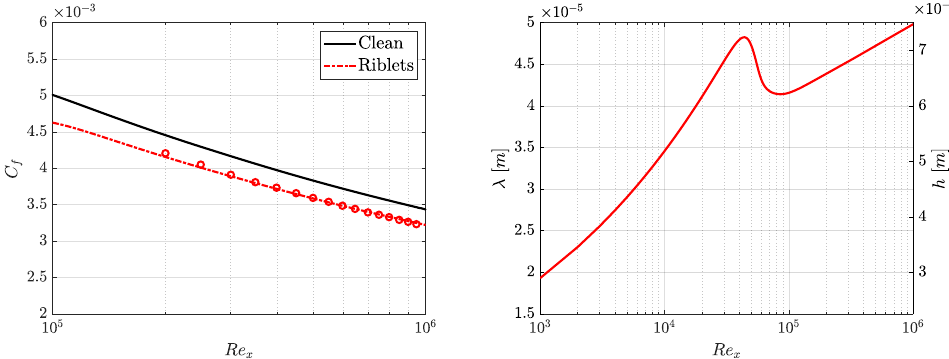
Figure 2. Zero-pressure-gradient boundary layer over a flat plate. Left : evolution of the skin-friction coefficient with/without riblets, and comparison with data from ref. [15]; right : change along the plate of the slip length ( left y axis) and riblets height ( right y axis), in dimensional units.